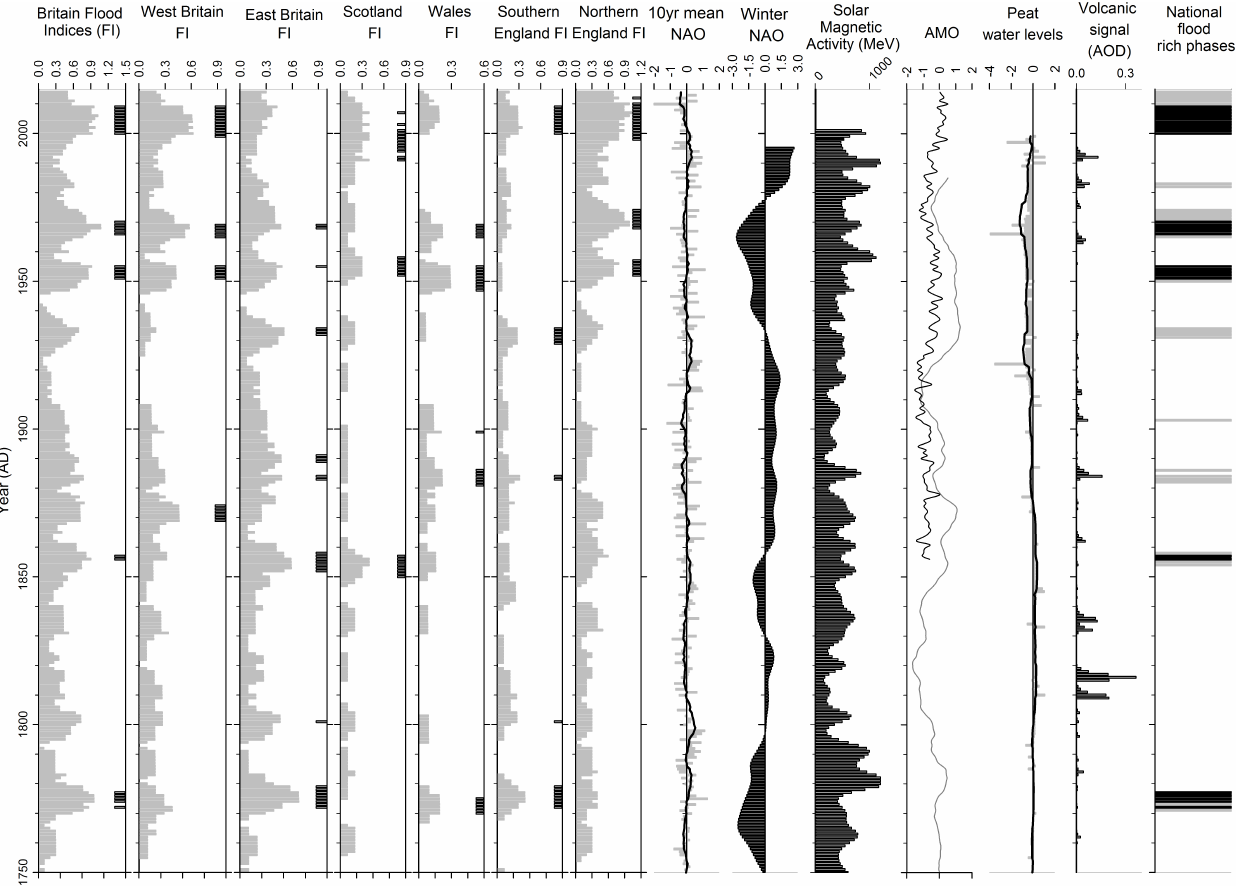
Figure 5. Historical flood chronologies (grey) by region and associated flood-rich periods (black) – Britain (1750–2014): west Britain FI (flood index); east Britain FI; Scotland FI; Wales FI; northern England FI; southern England FI; NAO reconstruction (with 10-year-running mean; Luterbacher et al., 2002); extended with CRU data; winter NAO (Trouet et al., 2009); solar magnetic (MeV; Muscheler et al., 2007); AMO grey (Gray et al., 2004) and black (Enfield et al., 2001); annual stacked peat water level (10-year-running mean; Charman et al., 2006); volcanic signal derived from aerosol optical depth (AOD; Crowley and Unterman, 2012); and national flood phases, using a 0.9 threshold (black) and 0.8